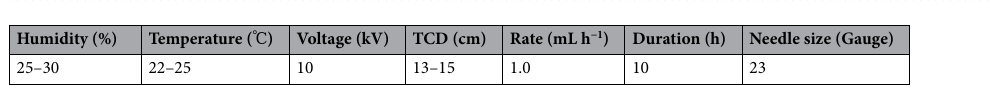
Figure 5. Electrospinning of the shielding material to increase its dispersion power. ( a ) Magnified images of a morpho butterfly wing, and ( b ) result of implementing the same pattern through electrospinning.